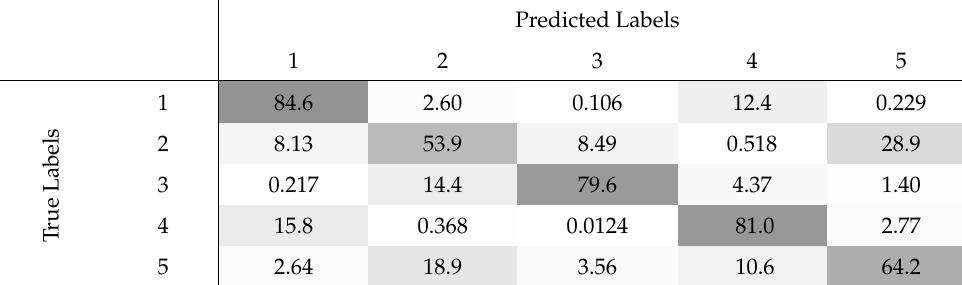
Table 1. Experiment I: Confusion matrix of our tree-based